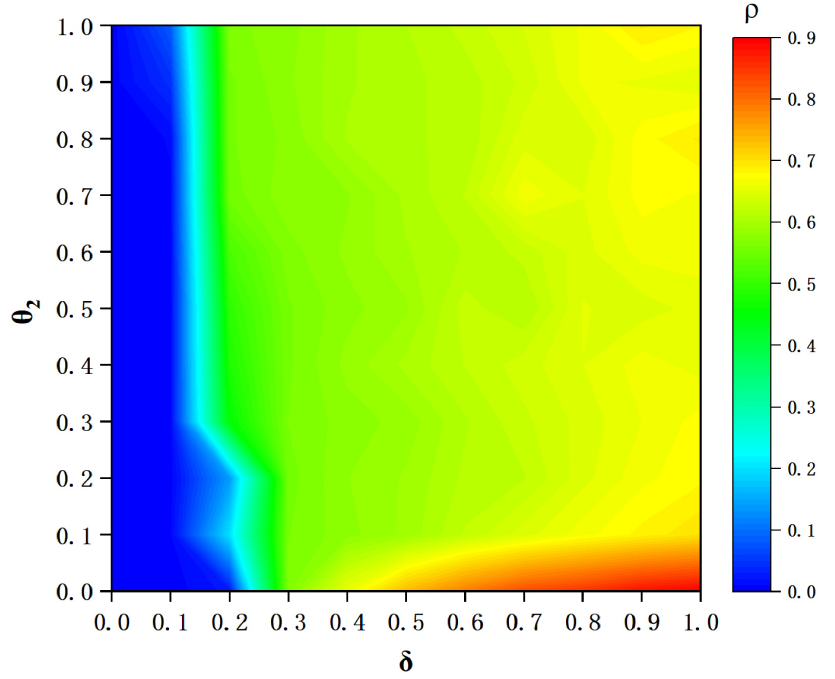
Fig 11. Heat-maps of cooperation frequency ρ at equilibrium along 2D plain based on positive sustained coefficient θ 2 and emotion coefficient δ . All kinds of colors represent various cooperation frequency under the joint action of different θ 2 and δ . The X-axis is δ (from 0 to 1) and the Y-axis is θ 2 (from 0 to 1).